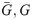
Effectiveness on Add Health Networks over a Range of Transmission Rates.We use the same visualization scheme as in Fig 2 and the medium immunization coverage of 10% on networks based on a typical school network from the Add Health study. We varied β to produce both small and large outbreak sizes. For panel (A), the measured value of R0 was 1.40, and the mean outbreak size with no immunization was 11.12% of the population. For panel (B), the measured value of R0 was 3.34, and the mean outbreak size with no immunization was 75.68%. For panel (C), the measured value of R0 was 3.84, and the mean outbreak size with no immunization was 86.23%. The legend lists all strategies tested: betweenness (Bet), degree (Deg), self-reported degree (S.R.D), and all variants of acquaintance immunization (Acq(G′, G′), Acq(G′, G), Acq(G¯,G), and Acq(G, G)).